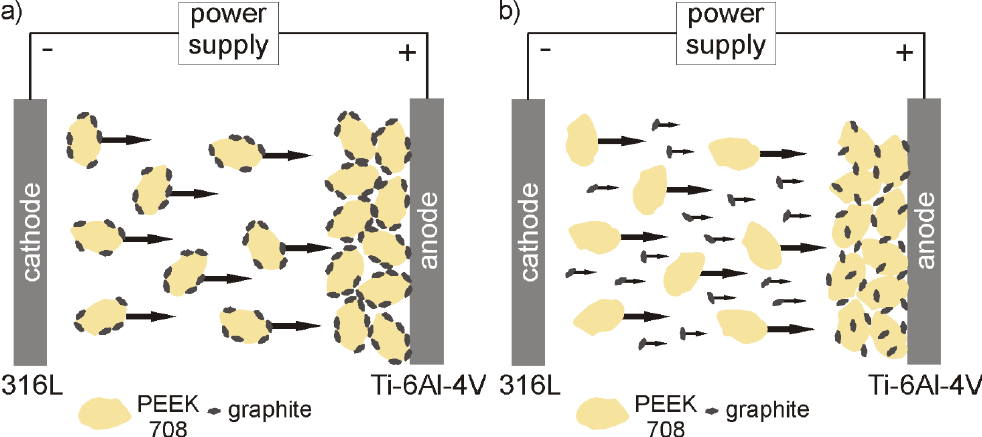
Figure 5. Schematic drawings of the possible co-deposition mechanism of the graphite and PEEK 708 particles from ethanol showing the adsorption of graphite on the PEEK surface and deposition of complexes on the anode ( a ), and independent deposition of both types of particles on the anode ( b ). The selection of the basic deposition parameters, voltage and time, was performed in an experimental way, and the preliminary evaluation of the coating homogeneity was carried out by macroscopic observations. The coatings were macroscopically homogeneous and repeatable after